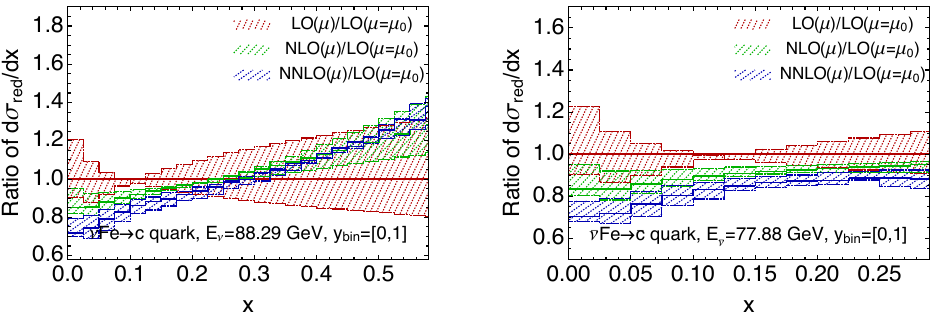
Figure 2 . QCD predictions including scale variations at di(cid:11)erent orders for a di(cid:11)erential reduced cross section in Bjorken x for charm (anti-)quark production from (anti-)neutrino scattering on iron